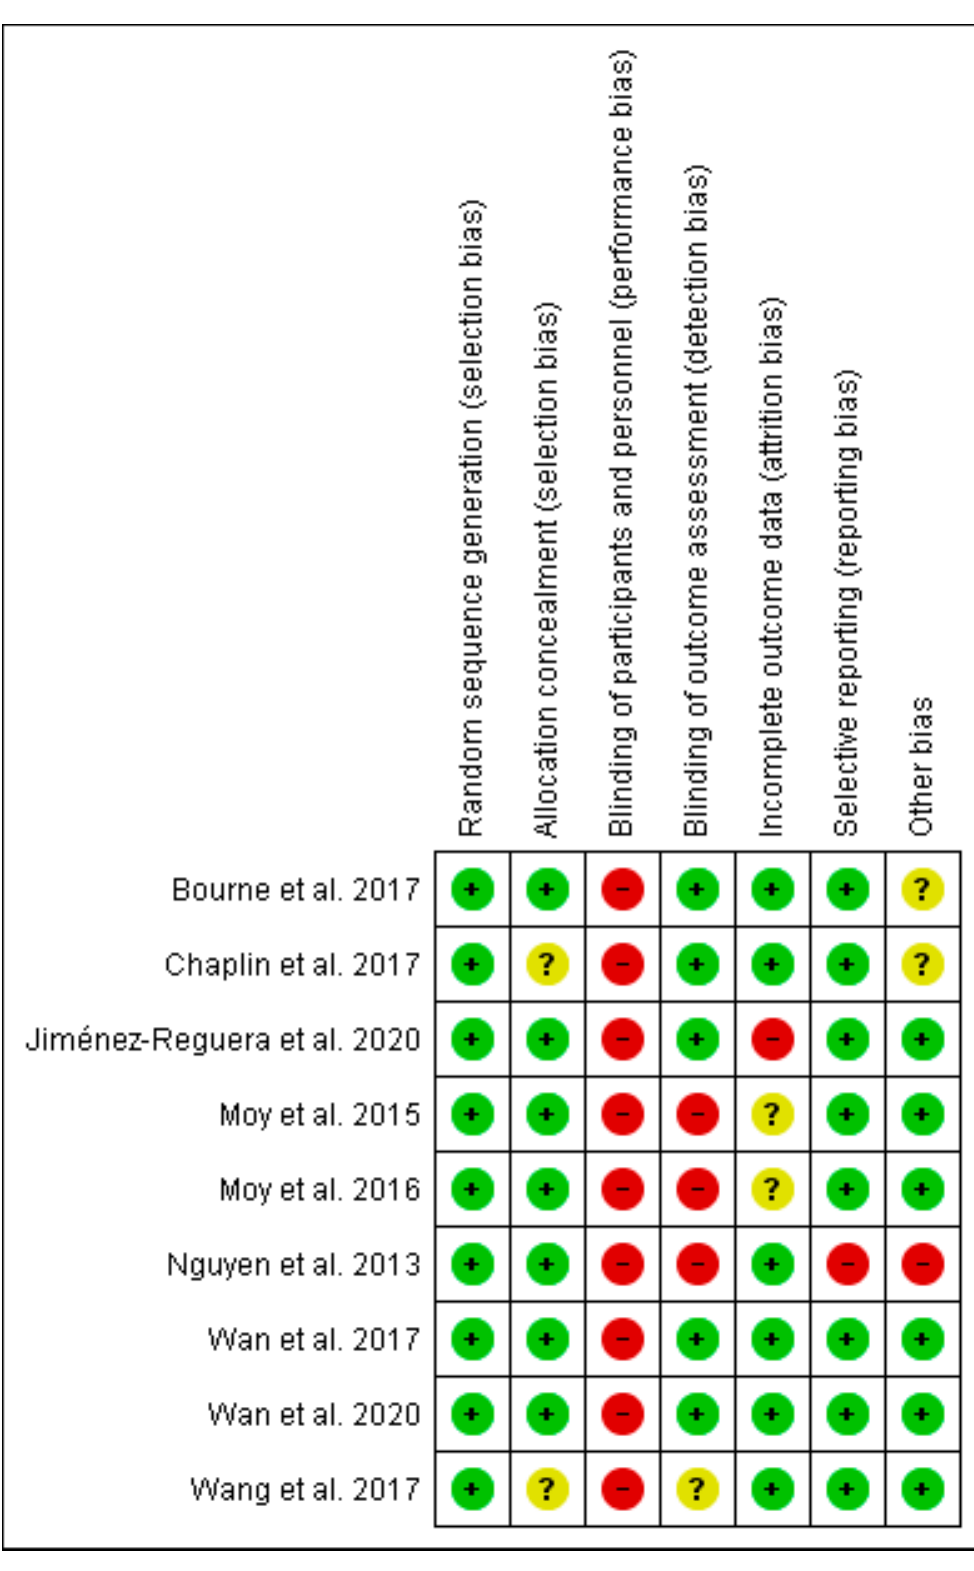
Figure 2. Risk of bias assessment of included studies. Notes: red, high risk of bias; yellow, moderate risk of bias; green, low risk of bias.